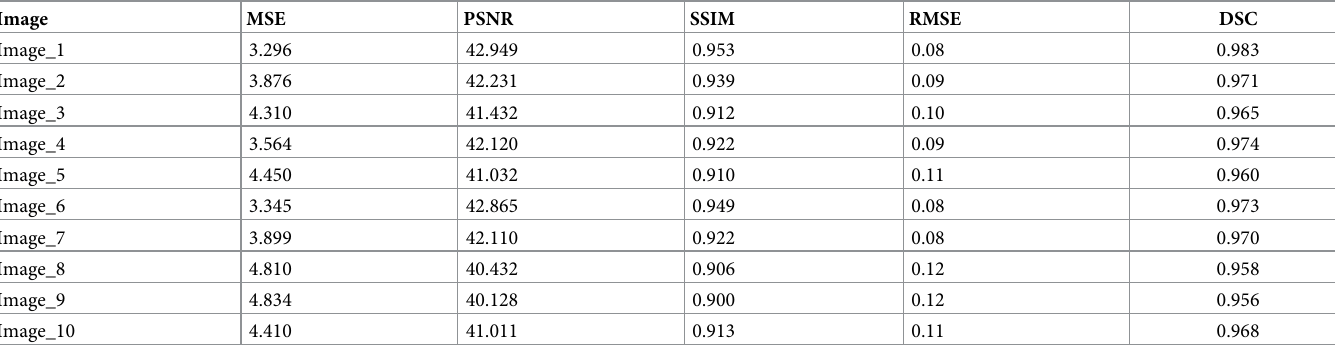
Table 7. MSE, PSNR, SSIM, RMSE and DSC of 10 images.